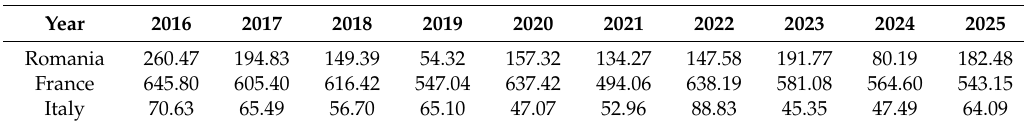
Table 8. Estimation of global bioethanol potential of a region (TJ). Source: authors’ own calculation based on [56].